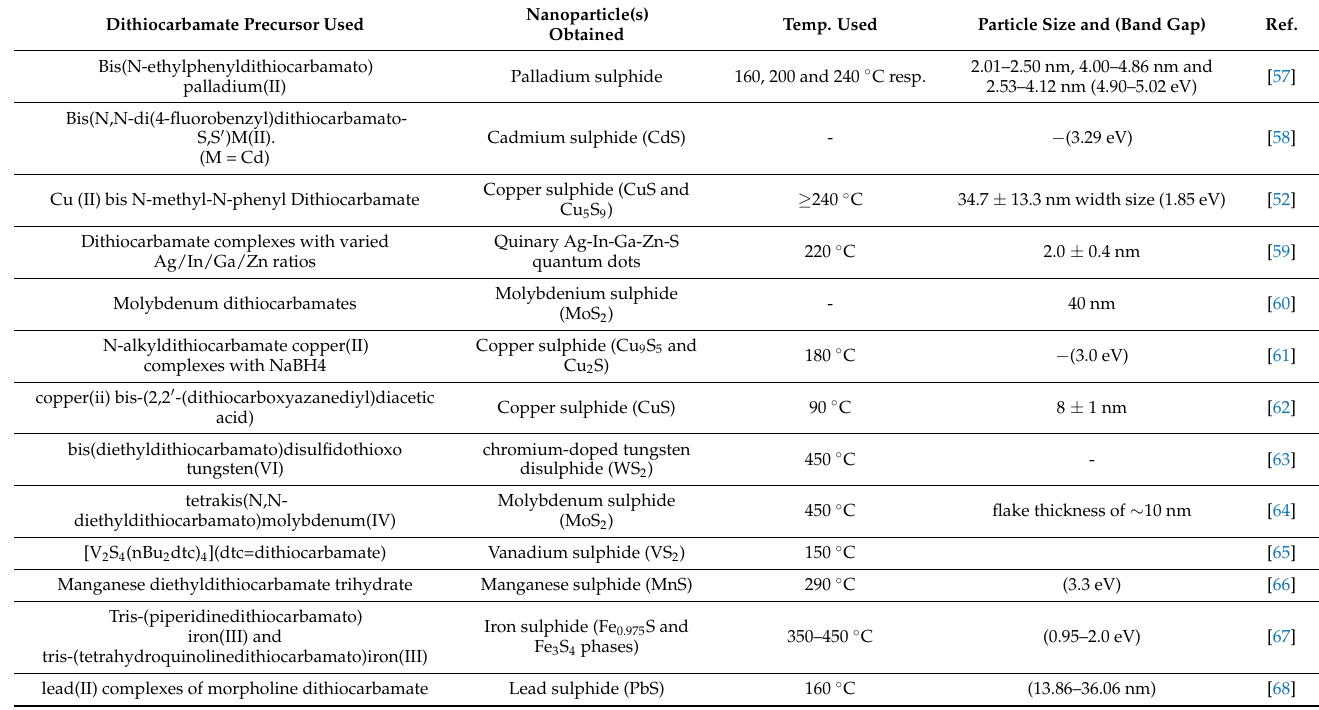
Table 3. Application of dithiocarbamates in nanoparticle